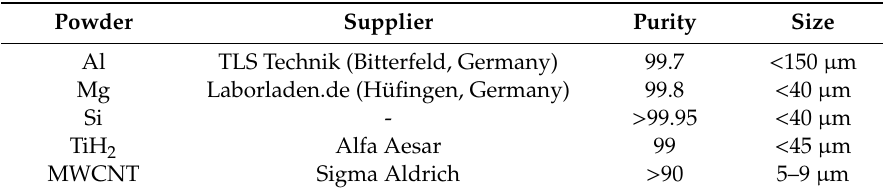
Table 1. Characteristics of powders used as starting